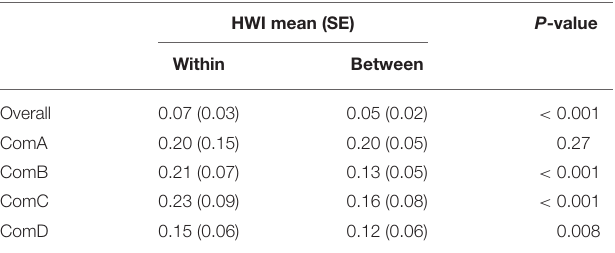
TABLE 3 | Association indices within and among sex classes (Mantel test, 0.05 one-side).